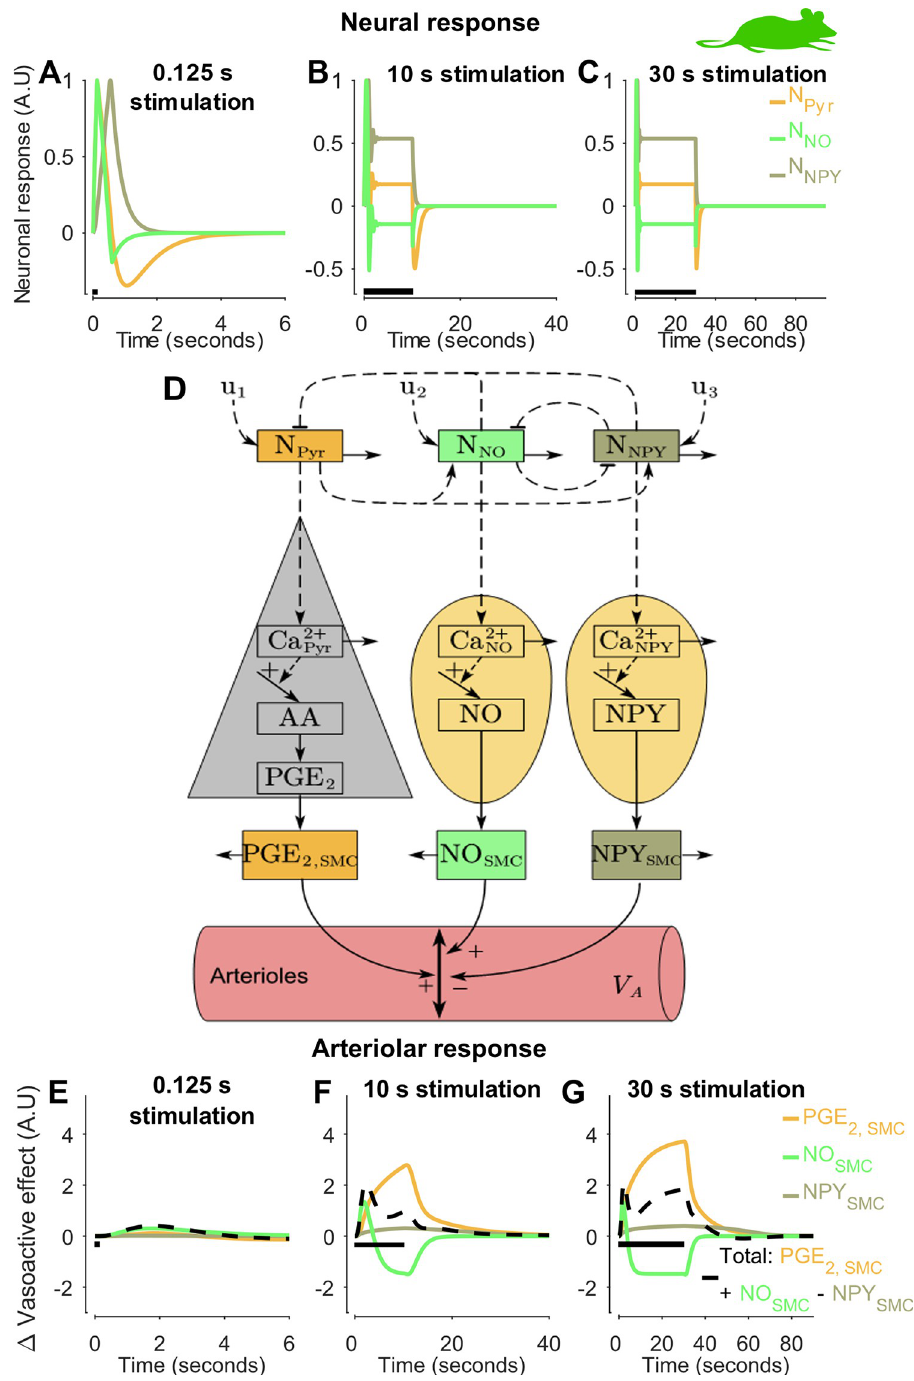
Fig 4. The model explanation for two-peak behavior in Drew data: mechanistic insights to be preserved and translated (Section 2.1.2) [46]. Model simulations for the three stimulus durations: 125 ms (A & E), 10 s (B & F), and 30 s (C & G) are shown. For each stimulus: the dynamic of the neuronal states, pyramidal neurons (N Pyr) , GABAergic nitric oxide interneurons (N NO ), GABAergic neuropeptide Y interneurons (N NPY ), (A–C), and the arteriolar response (E–G). For each graph: model simulation (colored lines); stimulus length (black bar). The x-axis represents time in seconds, and the y-axis is the change in neuronal states (A.U) for A–C, and the vasoactive effect on the arteriolar compartment (A.U) for E–G. In D, a simplified overview of the model is given. Here, u 1 , u 2 , and u 3 are the stimulus input to the model and are applied for 125 ms, 10 s, and 30 s for each respective experimental setting. The